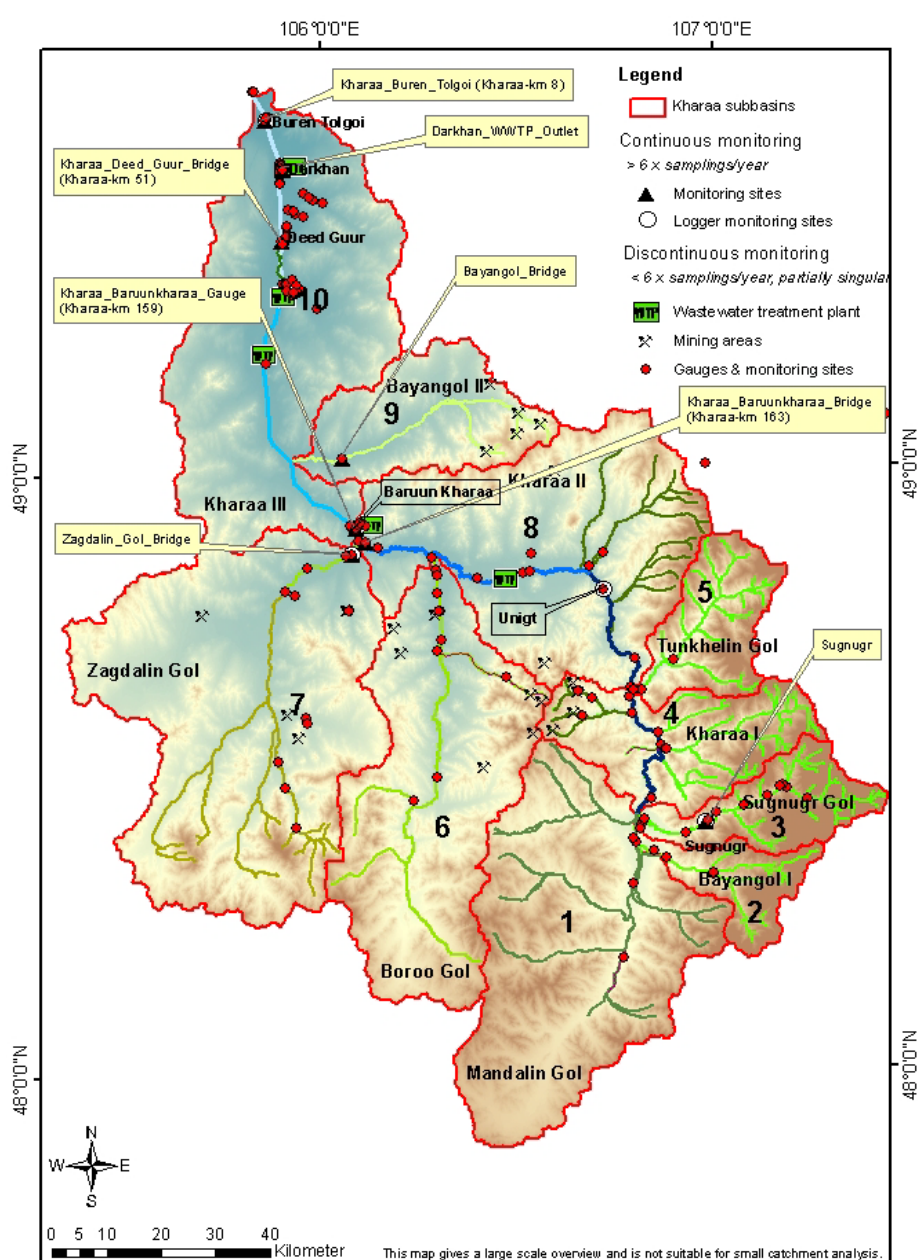
Figure 3. Continuous and discontinuous water quality monitoring in the KRB. In addition, the location of mining areas, contaminated areas and wastewater treatment plants (WWTP) is indicated. The numbers in black refer to the hydrological sub-basins in the text. The color of river network is explained in Figure